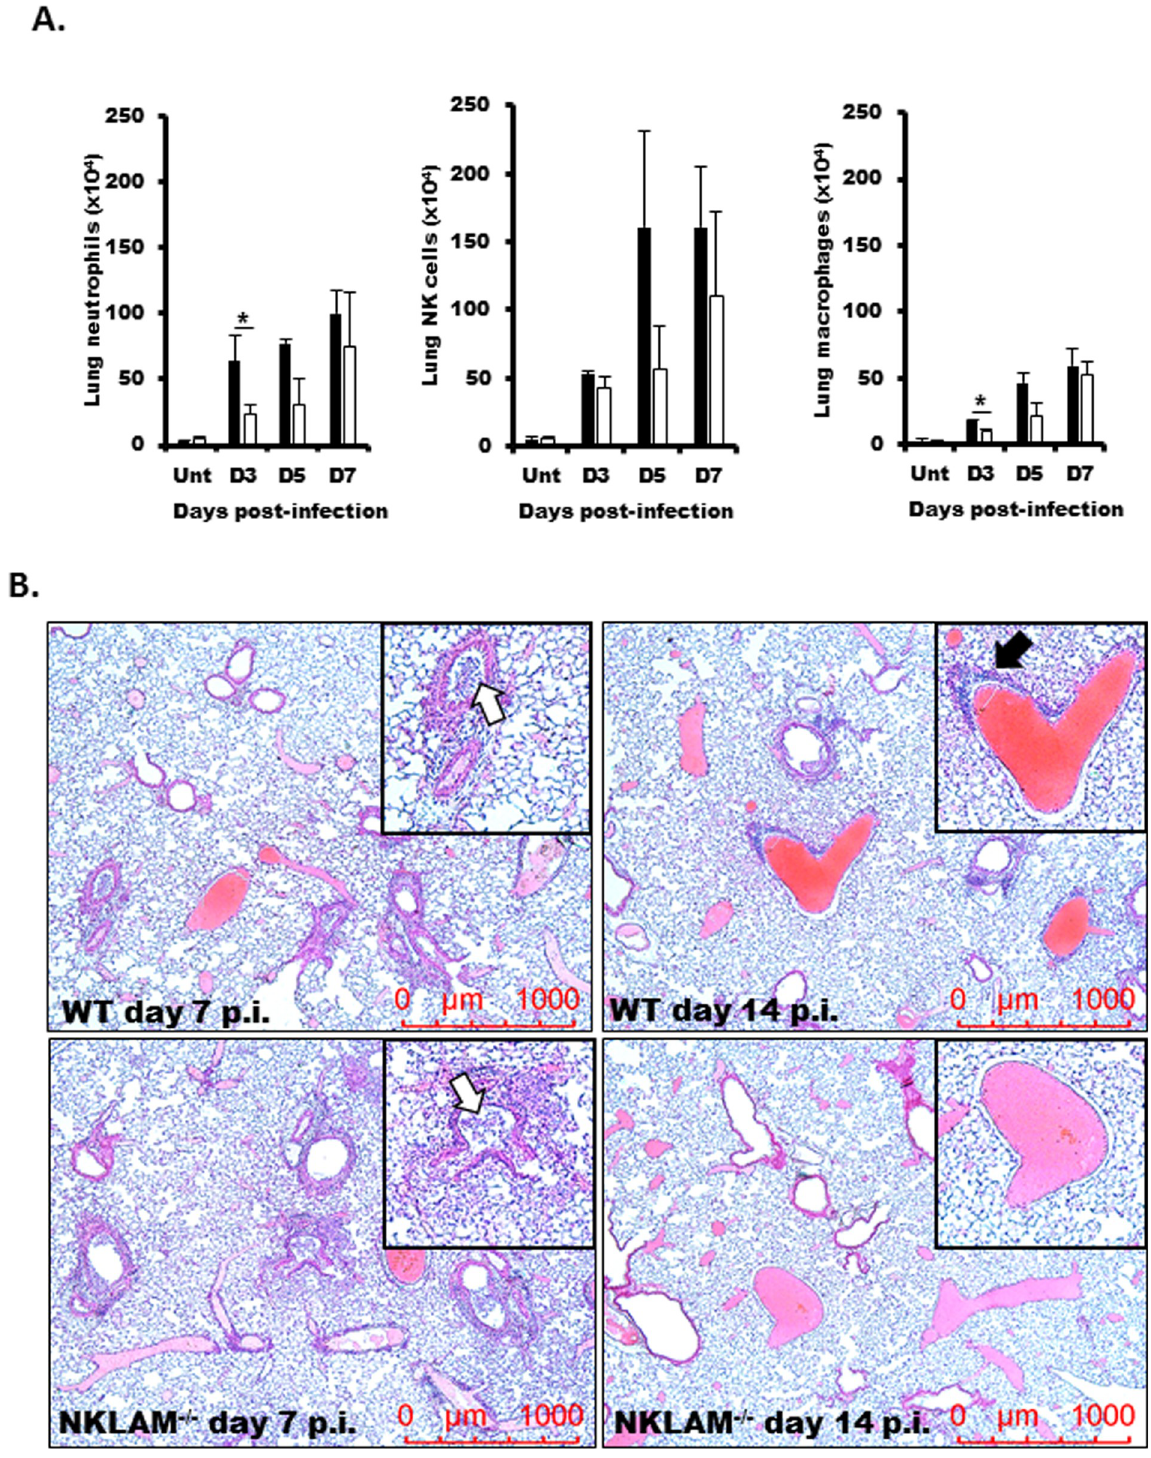
Fig 6. Examination of leukocyte infiltration into the lungs during SeV infection. WT and NKLAM -/- mice were uninfected (Unt) or infected with 500 pfu SeV/gram body weight. A) Lungs were dissociated into single cell suspensions were isolated at day 3, 5, and 7 post-infection and stained for CD45, CD3, NK1.1, CD11b, Gr-1 and F4/80. CD45 + cells were gated and the number of CD11b + /Gr-1 + , CD3 - /NK1.1 + or CD11b + / F4/80 + cells was determined; � p < 0.05; n = 3 mice per group, comparing NKLAM -/- and WT mice. B) Lungs from post-infection (p.i.) day 7 and 14 were formalin-fixed, embedded in paraffin and sections were stained with H&E. n = 2 mice per condition. Original magnification x50.